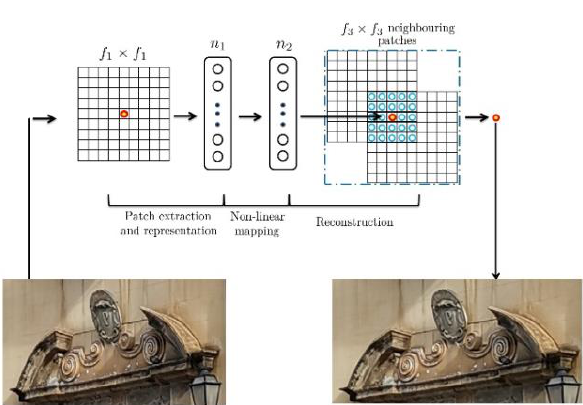
Figure 4: In the picture, there are two different layers: f 1 xf 1